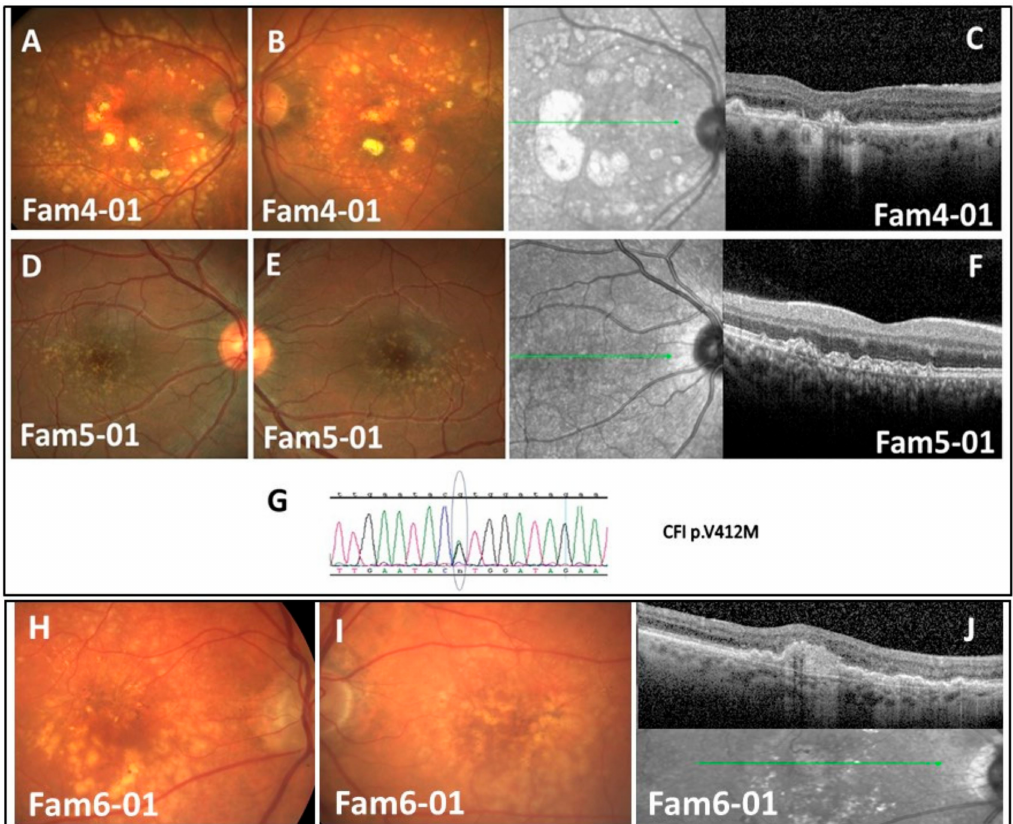
Figure 1. Clinical findings and sequencing results for families 4,5 with CFI p.V412M and family 6 with C3 p.R735W. ( A , B ) Color fundus images of Fam4-01—demonstrating large confluent drusen extending beyond vascular arcades and patches of RPE atrophy; ( C ) SD-OCT image of Fam4-01—demonstrating central atrophy and scarring; ( D , E ) Color fundus images of Fam5-01—demonstrating bilateral drusen; ( F ) SD-OCT image—demonstrating drusen and drusenoid PEDs; ( G ) Family 4 and Family 5 sequencing results—CFI p.V412M; ( H , I ) Color fundus images of Fam6-01—demonstrating multiple